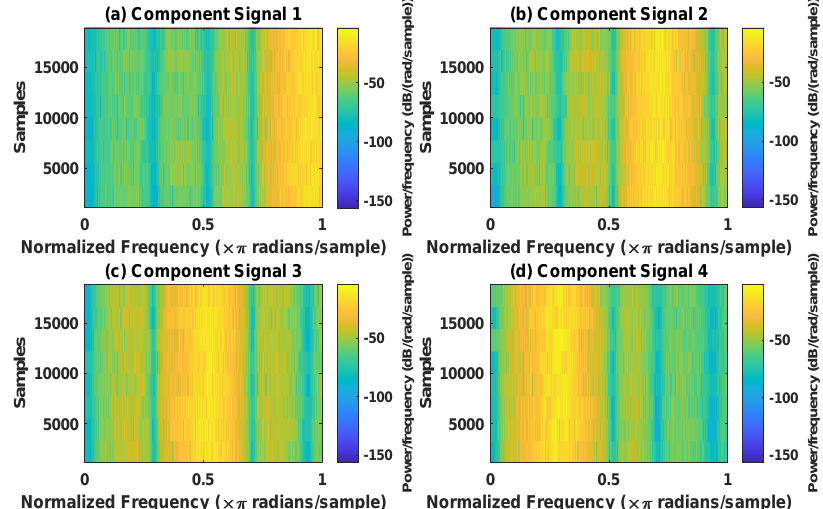
Figure 10. Decomposition results of VMD with m = 16: ( a – d ) time–frequency diagram of 1st to 4th subcomponents,